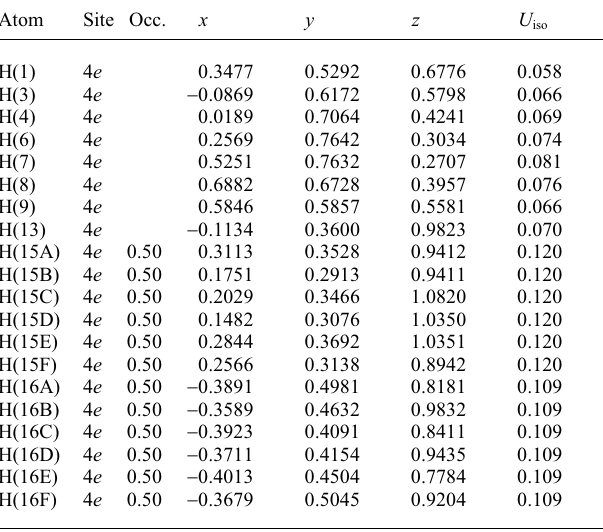
Table 2. Atomic coordinates and displacement parameters (in Å 2 )